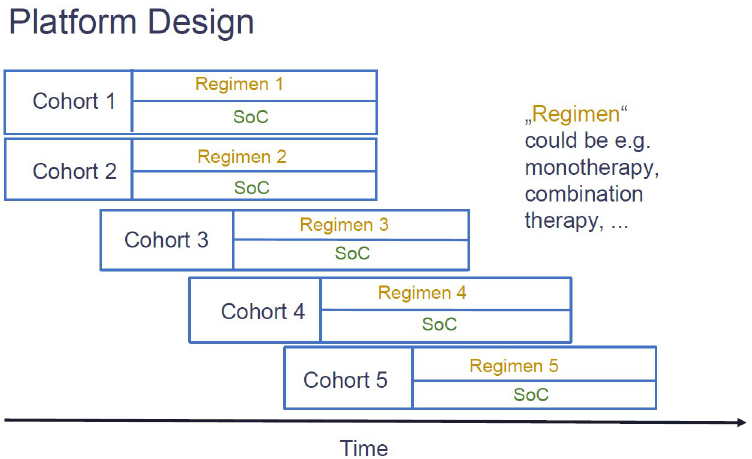
Fig 1. Phase 2b platform trial design in non-alcoholic steatohepatitis (NASH). After an initial inclusion of two cohorts consisting of control (usually the standard-of-care, “SOC”) and “regimen” arm (which could be a monotherapy or a combination therapy), more cohorts of the same structure are entering the trial over time. Within each cohort, several interim and a final analysis are conducted using the co-primary binary endpoints “NASH resolution without worsening of fibrosis” and “Fibrosis improvement without worsening of NASH”. The platform trial ends when all cohorts have been evaluated.